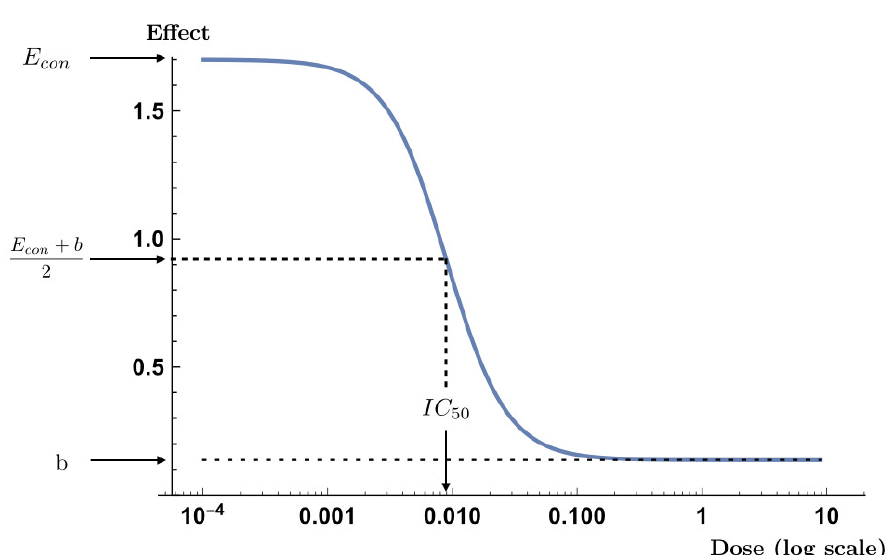
Figure 1. Graph of the regression function η ( x ; θ ) of the 4-parameter Hill model with nominal values corresponding to the drug TMTX, shown in Table 4.